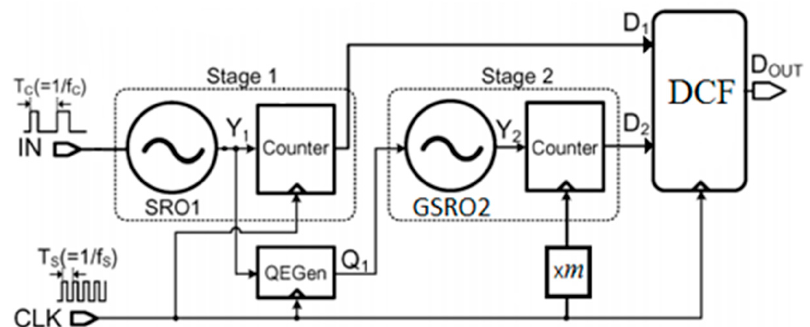
Figure 4. Block diagram of the 1-1 MASH multirate structure.